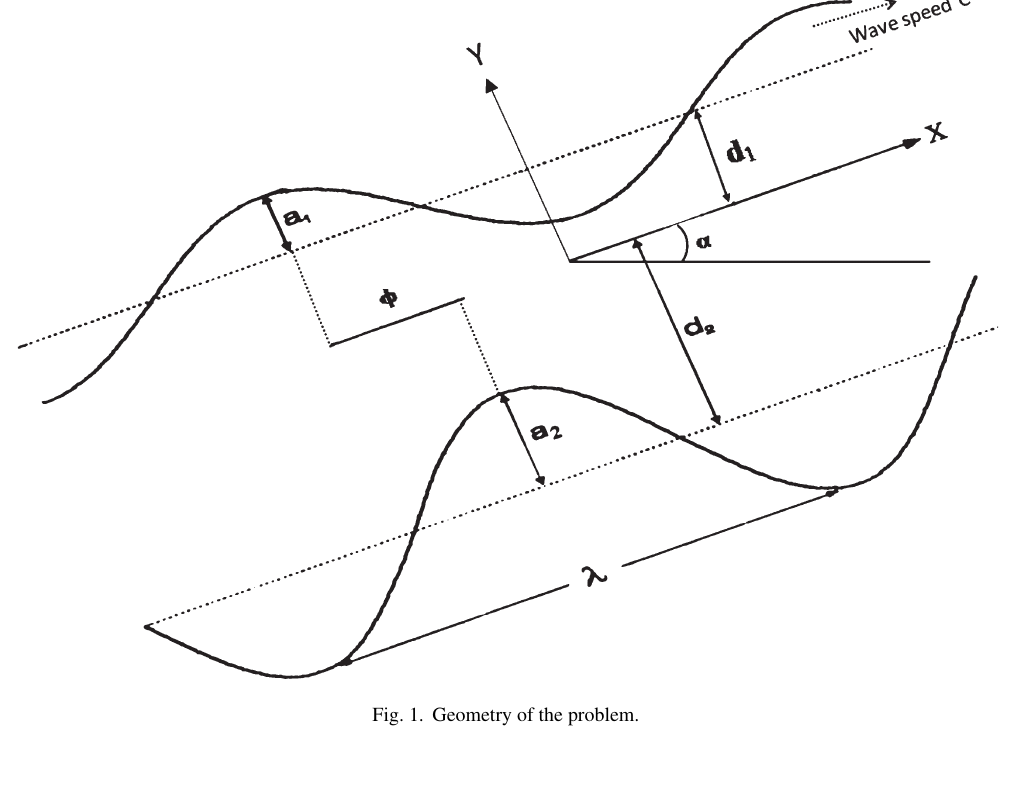
Fig. 1. Geometry of the